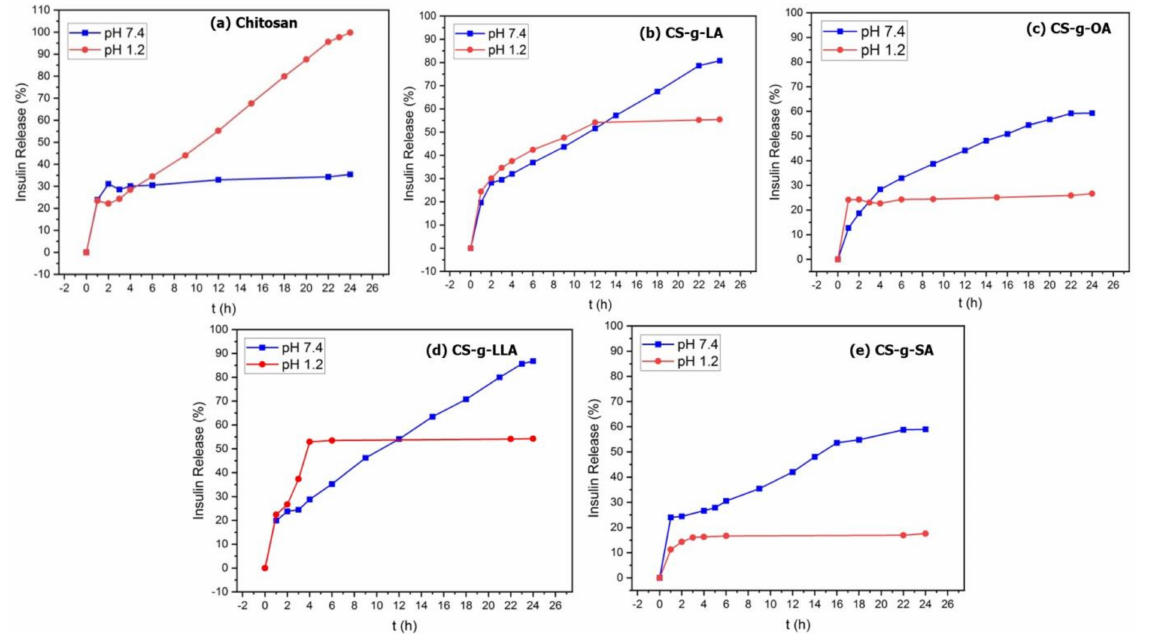
Figure 6. Insulin drug release profiles of pure CS and fatty-acid-modified CS at two different pHs of 1.2 and 7.4. ( a ) Pure CS, ( b ) CS-g-LA, ( c ) CS-g-OA, ( d ) CS-g-LLA, and ( e )